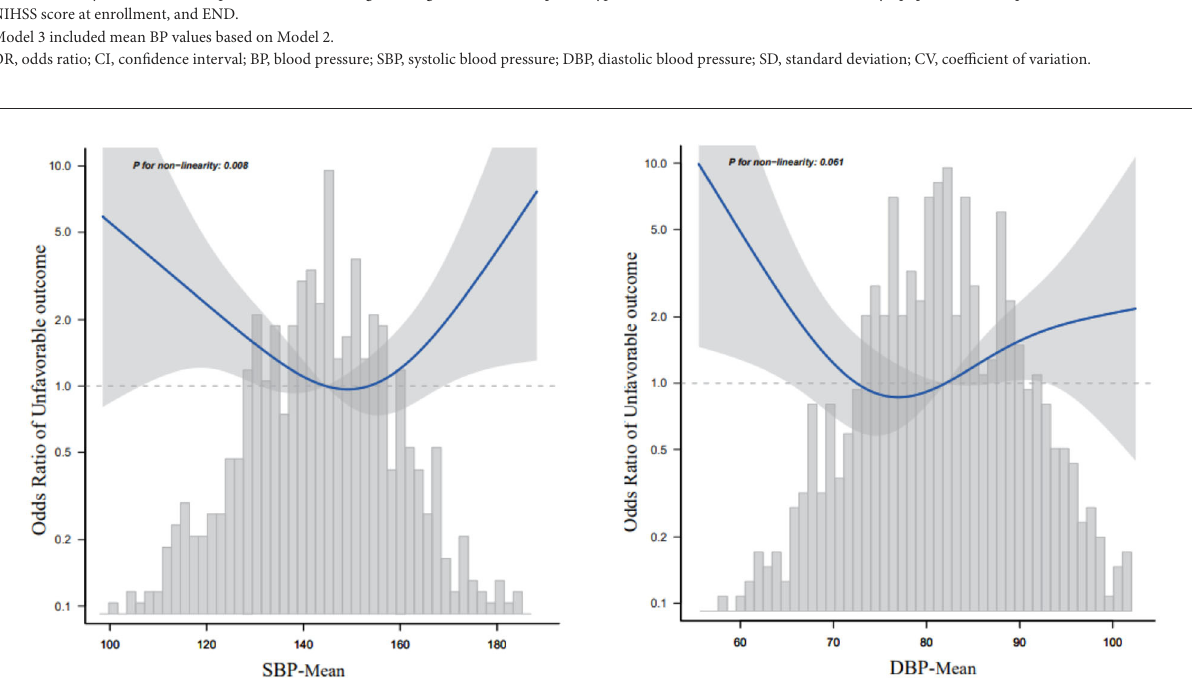
FIGURE2 Relationship between mean blood pressure and 3-month adverse outcomes according to the smooth curve-fitting analysis. Adjusted for age, sex, smoking, alcohol consumption, HT, fasting plasma glucose at enrollment, low-density lipoprotein, neutrophils, TOAST classification, NIHSS score at enrollment, and early neurological deterioration. Only 95% of the data are